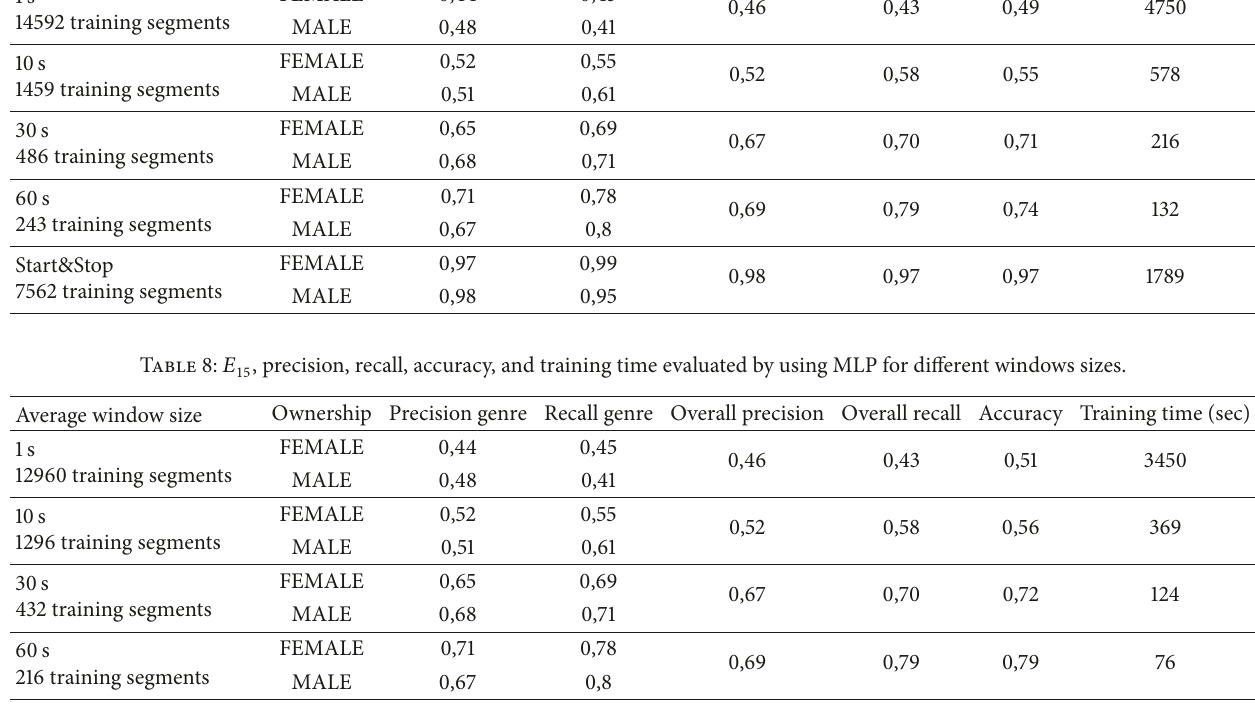
Table 7: 𝐸 14 , precision, recall, accuracy, and training time evaluated by using MLP for different windows sizes. Average window size